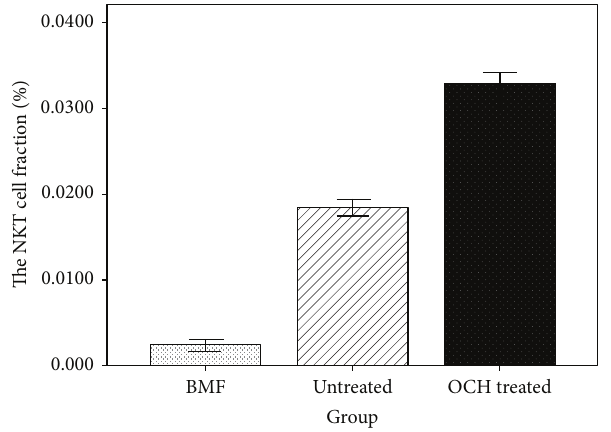
Figure 5: A fraction of NKT cells in BMMNCs. On d60 after BMF induction, NKT cell percentages of BMMNCs from BMF, untreated, and OCH groups were analyzed. Compared with the untreated group, there were fewer NKT cells of BMMNCs in BMF group ( 𝑃 < 0.01 , by ANOVA, 𝑛 = 7 ). NKT cell population was increased in OCH group. The NKT cell percentage of BMMNCs was found with statistical differences between the OCH group and BMF group ( 𝑃 < 0.01 , by ANOVA, 𝑛 = 7